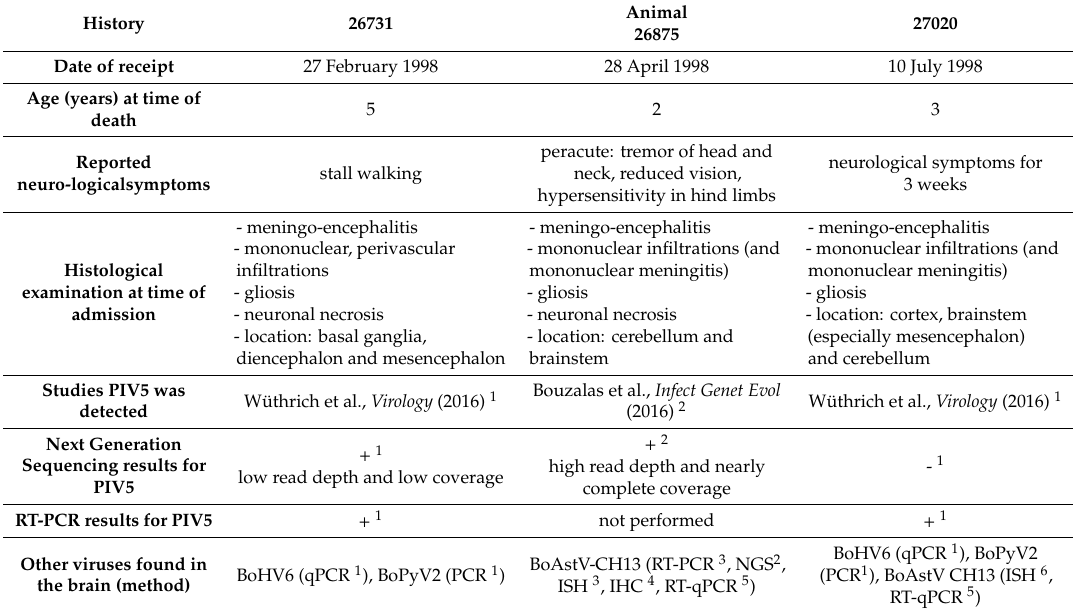
Table 1. History and initial testing results of the three PIV5-positive animals from previous